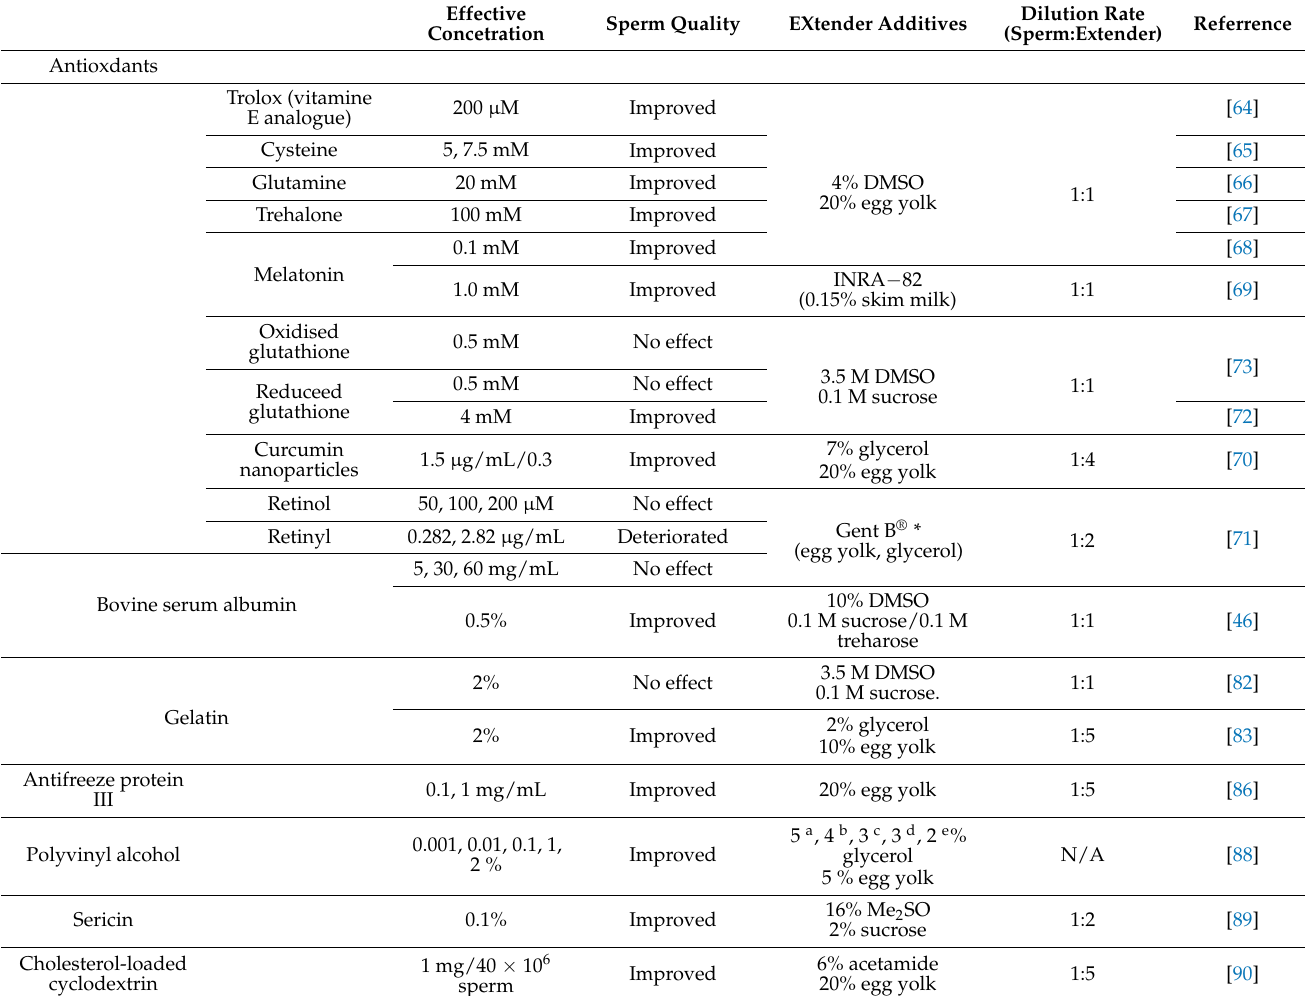
Table 1. Effects of supplements on quality of thawed rabbit sperm frozen by slow freezing